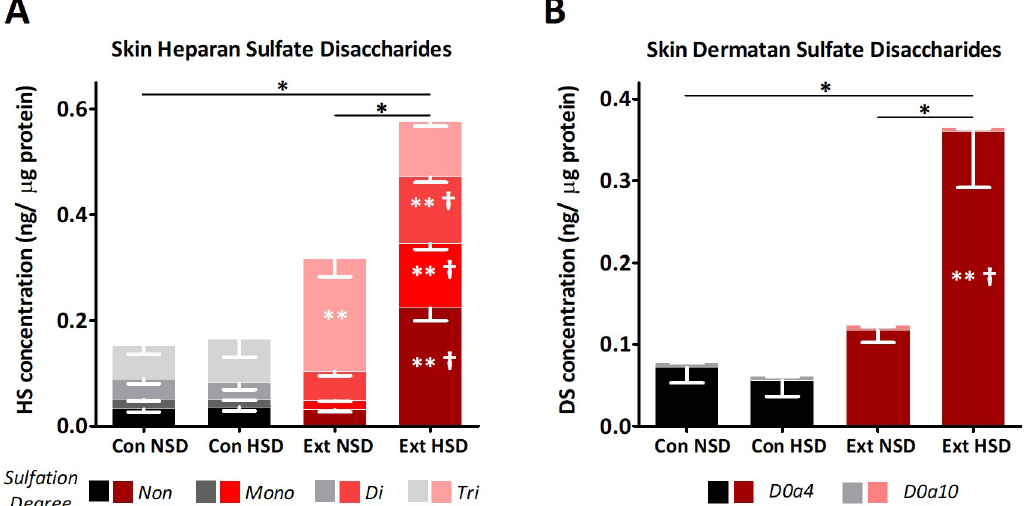
Fig 1. Altered skin GAG content and sulfation in Ext1 +/- Ext2 +/- mice. Results from HPLC-MS/MS measurements of skin heparan sulfate (A) and dermatan sulfate (B) content and sulfation in Ext1 +/- Ext2 +/- and control mice. (A) No difference in total skin heparan sulfate content was seen between Ext1 +/- Ext2 +/- mice and controls on a NSD, but tri-sulfated heparan sulfate disaccharides were more prevalent in the skin of Ext1 +/- Ext2 +/- mice. After a HSD, total skin heparan sulfate disaccharide content increased in Ext1 +/- Ext2 +/- mice (p = 0.004) while no effect was seen in controls (p = 1.00; n = 5–6 for each condition). (B) Similar results were found for dermatan sulfate disaccharides (n = 5–6 for each condition): total skin dermatan sulfate disaccharide content was similar in Ext1 +/- Ext2 +/- mice and controls (p = 0.25) and increased after HSD in Ext1 +/- Ext2 +/- mice (p = 0.002), but not in controls (p = 0.84). � p < 0.05; �� compared to control mice on a similar diet; †compared to Ext1 +/- Ext2 +/- on a NSD. Con, controls; DS, dermatan sulfate; Ext, Ext1 +/- Ext2 +/- ; HS, heparan sulfate; HSD, high sodium diet; NSD, normal sodium diet.